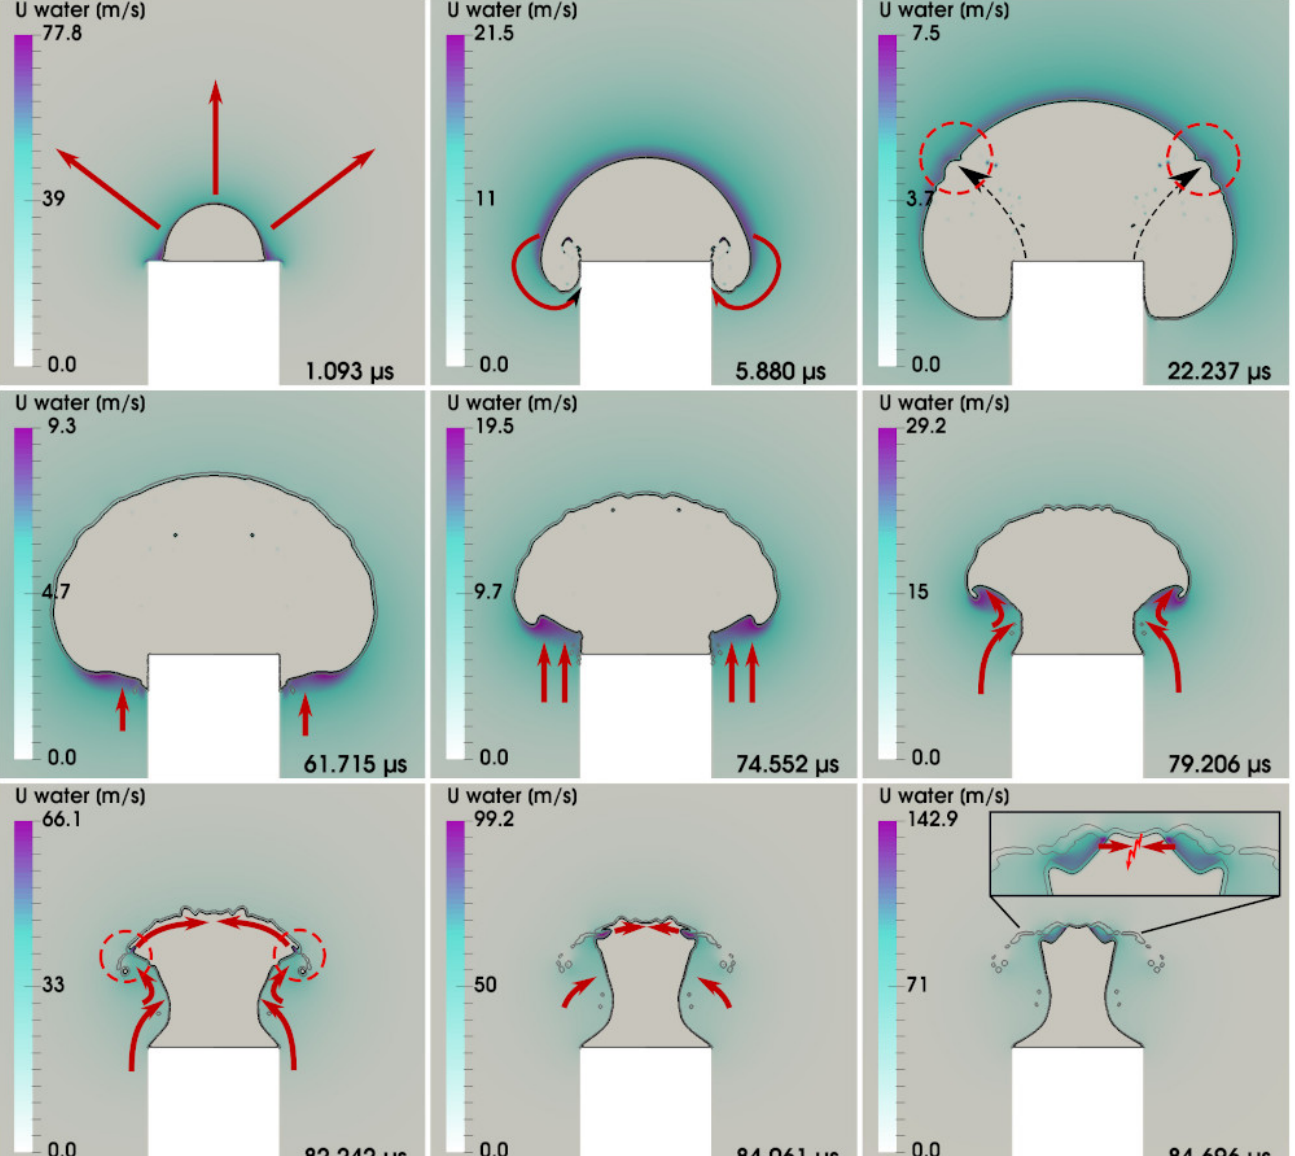
Figure 14. General dynamics of a mushroom bubble, part 1 shown using the same bubble as in Figures 10–13 ( R max,unbound = 472.57µm, D ∗ = 0.063, r ∗ p = 0.423, T Rc = 42.90µs): expansion and begin of collapse, plotted with the modulus of the liquid velocity field. The red arrows indicate the essential directions of the flow field. The dashed red circles in the upper right frame indicate (torus) droplets that impinge onto the inner bubble wall. The dashed red circles in the lower left frame point to the area of the shedding of sub-resolution (torus) bubbles from the rim of the collapsing mushroom head. They finally form the umbrella left after collapse of the mushroom head. (see also Figure 15). Cylinder radius is